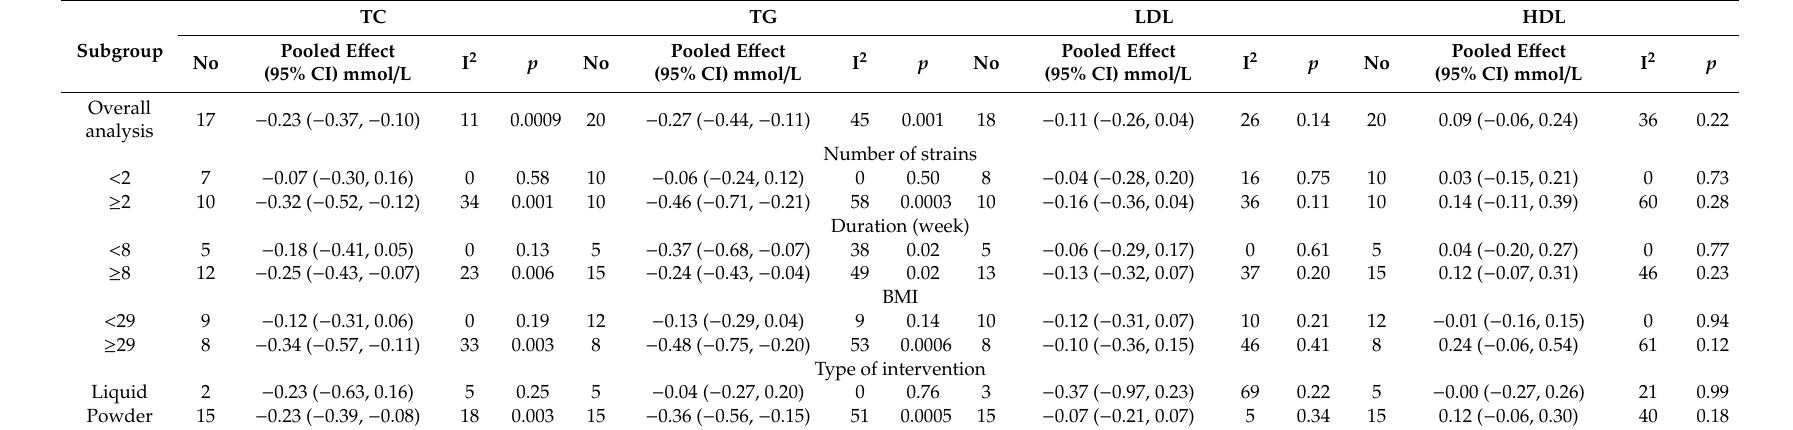
Table 2. Results of subgroup analyses for TC, TG, LDL-C and HDL-C levels in T2DM